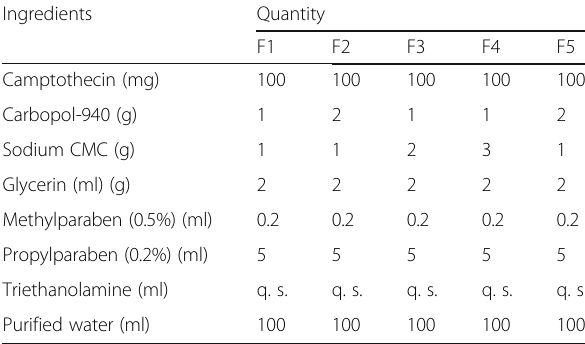
Table 1 Formulation table of camptothecin herbal gel